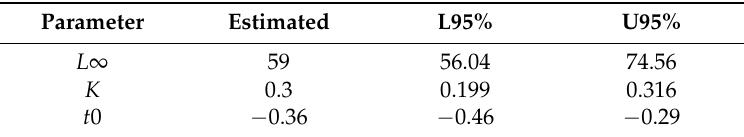
Table 1. Parameter estimates and predicted lower (L95%) and upper (U95%) confidence intervals